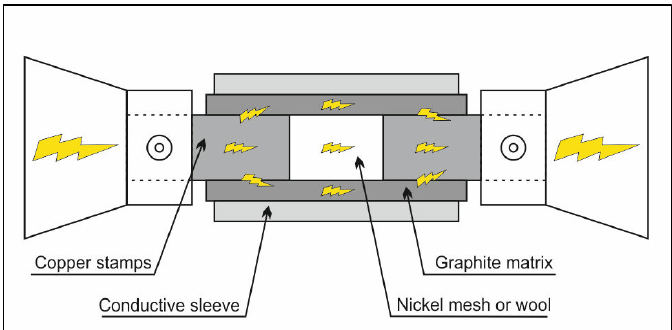
Figure 8. Scheme of preparation of the nickel support.